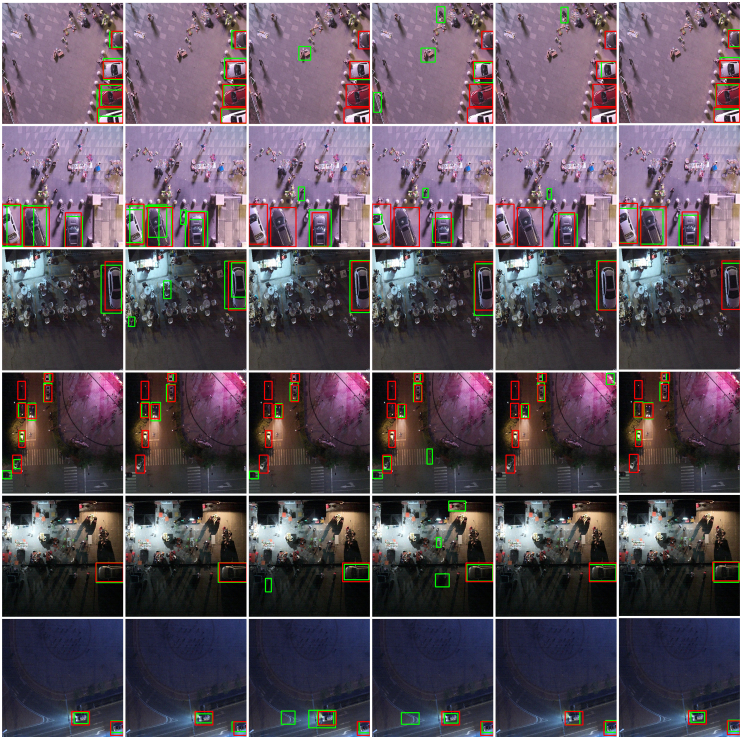
Figure 6. Samples of six fusion models in the visible images. From left to right are visible, infrared, fusion, BGR, Distangle-oriented and GF-detection. Red box denotes the ground-truth annotations, green is the predicted